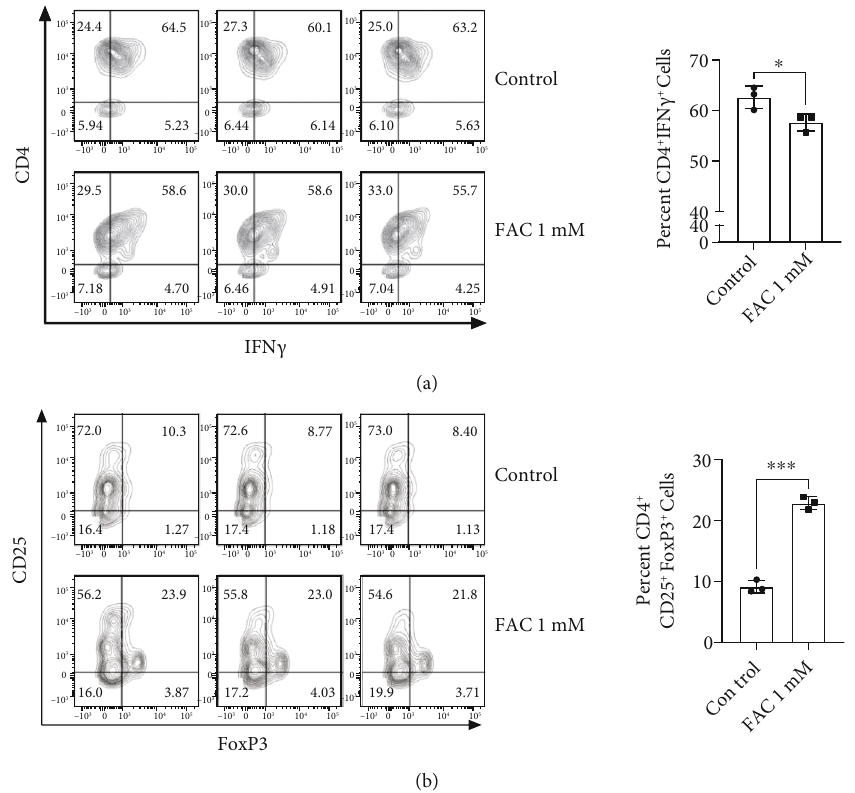
Figure 2: E ff ects of FAC-treated macrophages on CD4 + T cell polarization. C57BL/6J-derived macrophages were treated with 1 mM FAC for 16h. After washing with media, cells were coincubated with BALB/c-originated CD4 + T cells for 5d. The percentages of CD4 + IFN γ + Th1 cells (a) and CD4 + CD25 + Foxp3 + Treg cells (b) were measured by fl ow cytometry. ∗ indicates signi fi cant di ff erences ( ∗ P < 0 : 05 , ∗∗ P < 0 : 01